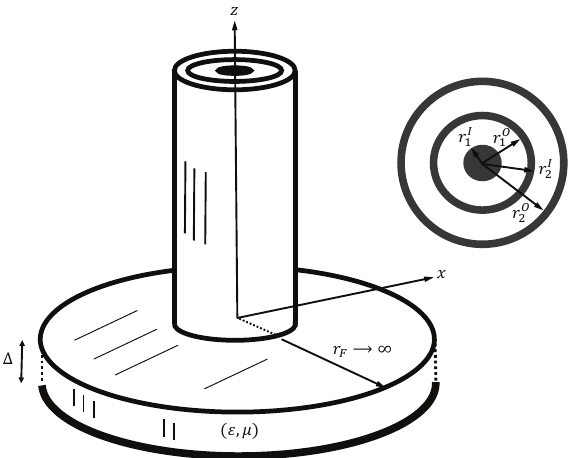
Figure 2. Simple theoretical model of the triaxial